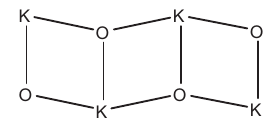
is completed by the N: → Li bond [e.g., Li(1)-N(7) 2.171(5) Å ], which is typical of those found in Li(dmae) [2.114(2) – 2.189(2) Å ] (Andrews et al., 2002) with each bdmap ligand bridging along one rim of the hexagon (rather than span- ning between hexagons). The 1 H NMR spectrum of 1 , which shows that the CH protons of the ligand are all equivalent, 2 implies a more dynamic structure in solution, with the arms of the bdmap ligand coming on and off within the timescale of the experiment. The potassium salt 2 crystallises with one molecule of alcohol per alcoholate and is tetrameric, i.e., [K(bdmap) (Hbdmap)] ( Figure 2 ). In its 1 H NMR spectrum, the signals 4 due to the CH, CH and CH protons show no separation 2 3 between the alcohol and the alcoholate, but a very broad signal integrating to one hydrogen at ca . 11.38 ppm is con- sistent with the HO group of the coordinated Hbdmap; the Hbdmap/bdmap signals. The structure is built around a